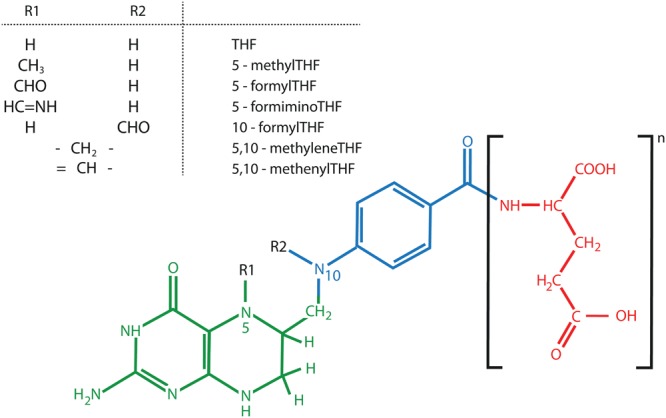
Chemical structure of folates (B9). The three different folate components, pterin (green), para-aminobenzoate (blue), and glutamate tail (red) are indicated. Here, a fully reduced tetrahydrofolate (THF) is presented. Figure adopted from (Strobbe and Van Der Straeten, 2017).